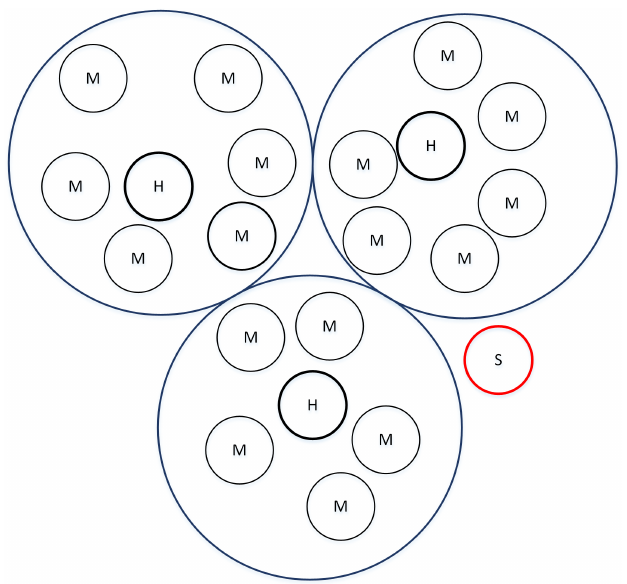
Figure 8. The clustering mechanism. H is a cluster head. M is a cluster member. S is the